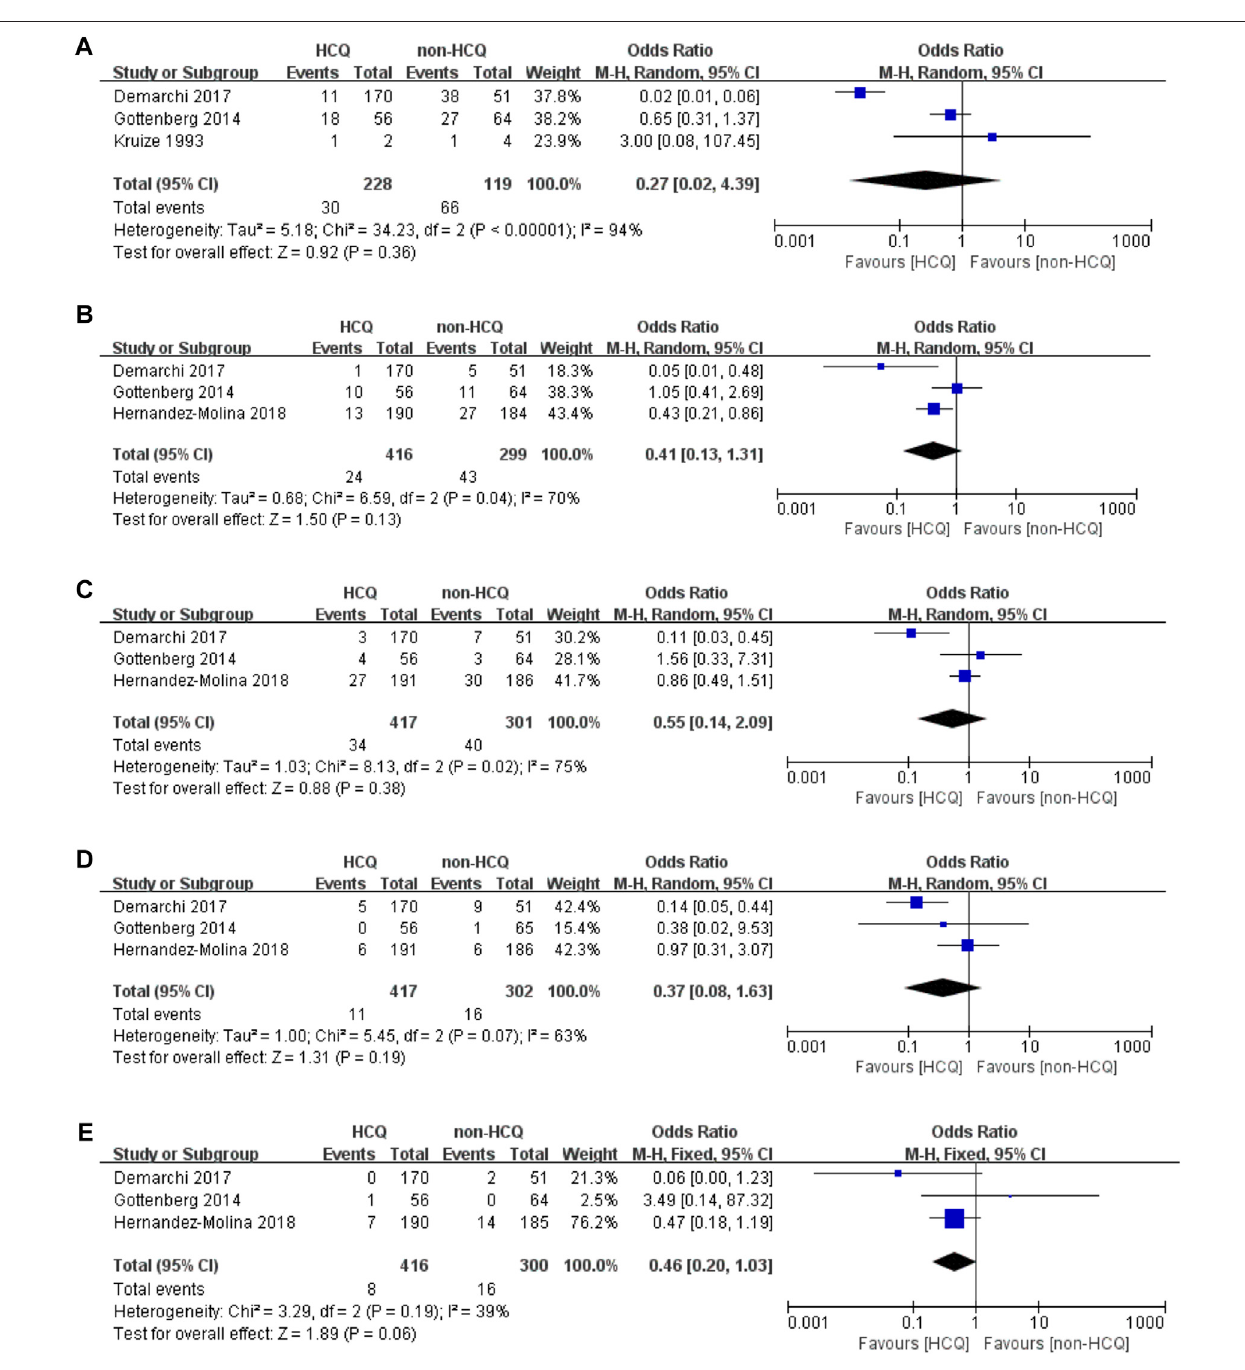
FIGURE 3 | Forest plot of studies comparing HCQ group and the non-HCQ group, examining the effect on pSS (including articular domain, pulmonary domain, neurological domain, lymphoproliferative domain and renal domain). (A) articular domain. (B) pulmonary domain. (C) neurological domain. (D) lymphoproliferative domain. (E) renal